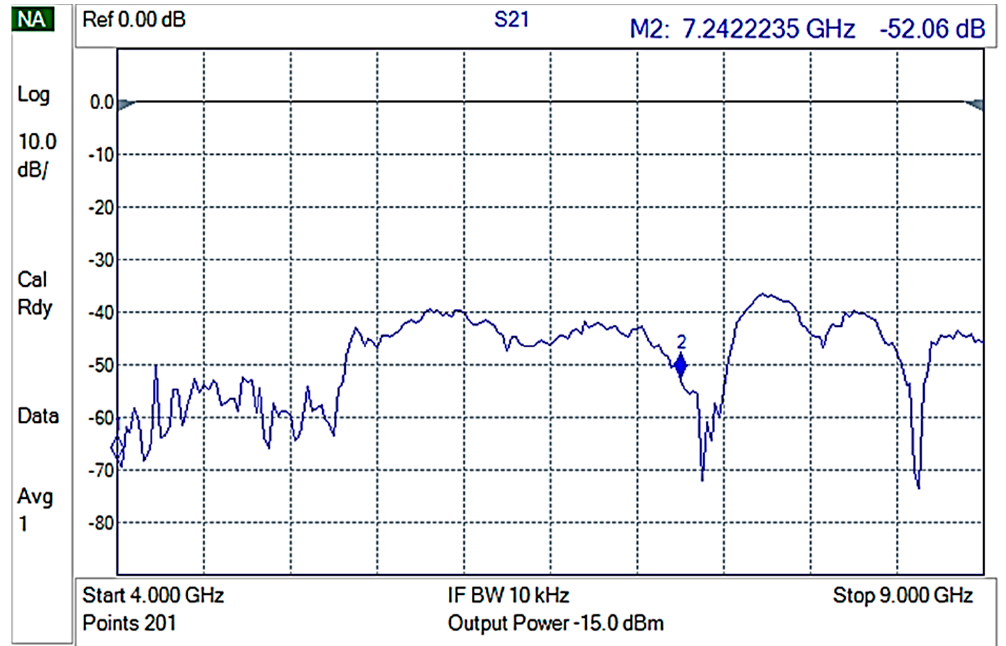
Figure 10. S21 for 10% CNTs-PP composite materials. A graphical representation of the attenuation efficiency of various materials at various frequencies is presented in Figure 11.